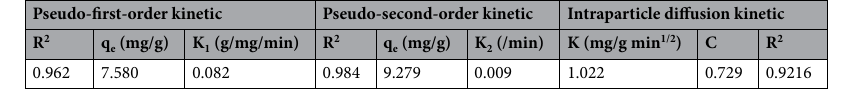
Table 8. The parameters of Kinetic models for AR18 adsorption.